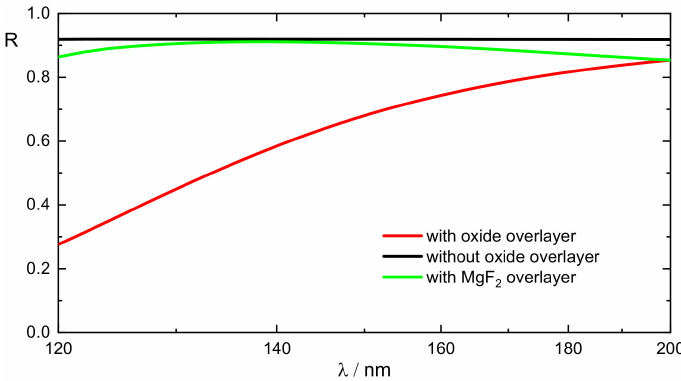
Figure 6. Calculated VUV-reflectance of different smooth aluminum